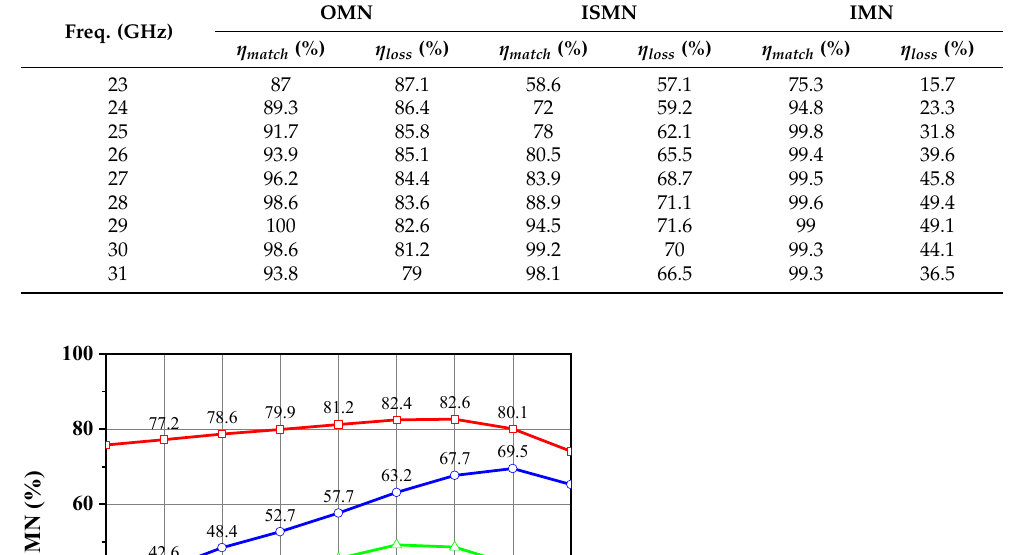
Table 3. η match and η loss of each MN across 23–31 GHz.